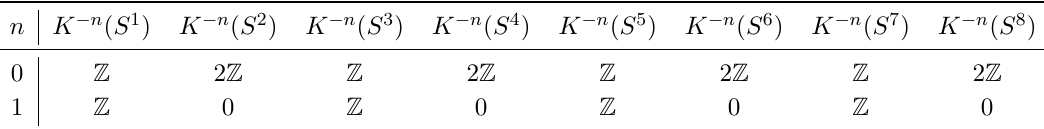
Table 26 . K-groups of spheres K n ( S k ) , k = 1 , . . . , 8 .